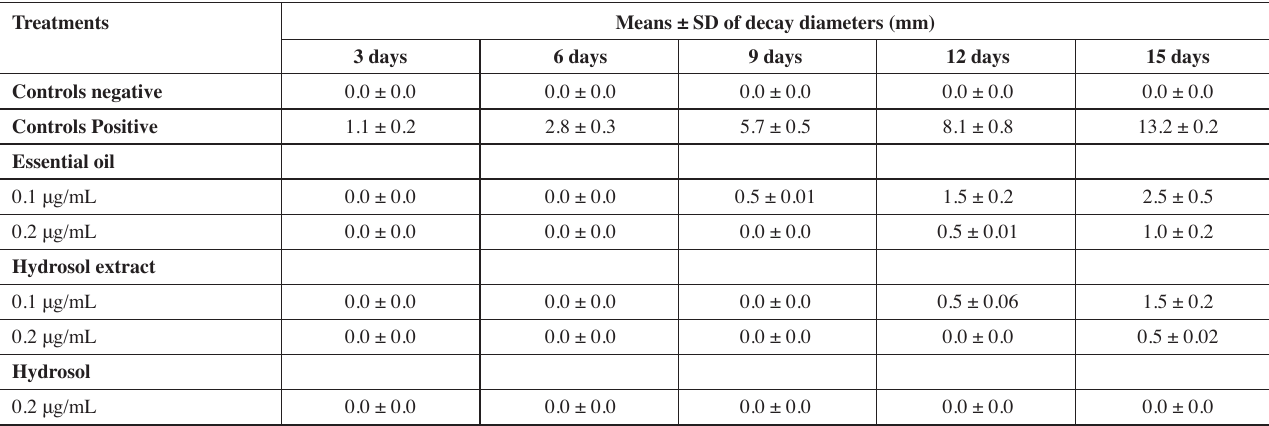
Tab. 3: Means of decay diameters (mm) measured after 3, 6, 9, 12 and 15 days on orange fruits treated with 0.1 or 0.2 μg/mL of essential oil, hydrosol extract and hydrosol from T. capitatus .